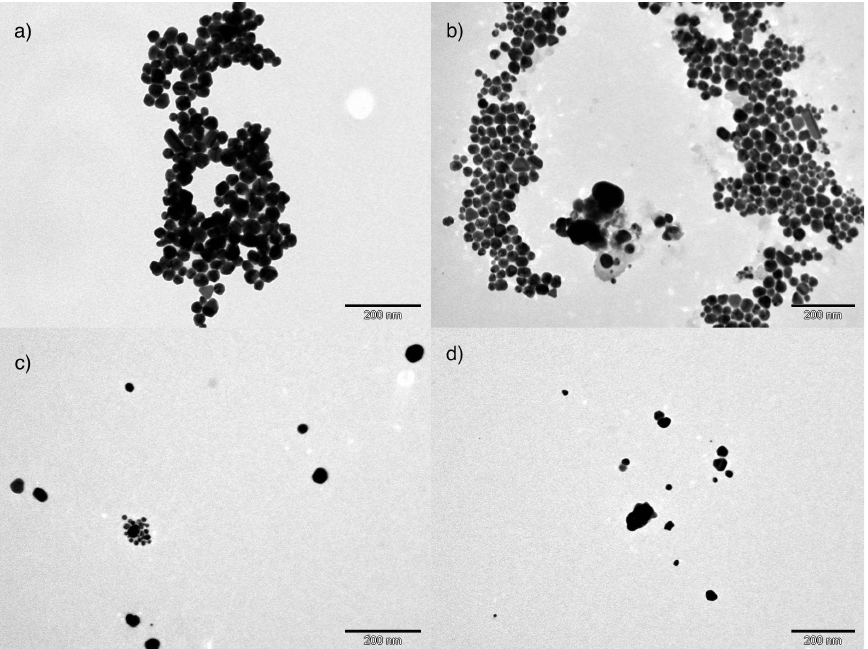
Figure 5. TEM images of silver NPs synthesized with extracts by SNPAC method: ( a ) white thyme; ( b ) eucalyptus; ( c ) oak; ( d ) white cedar.